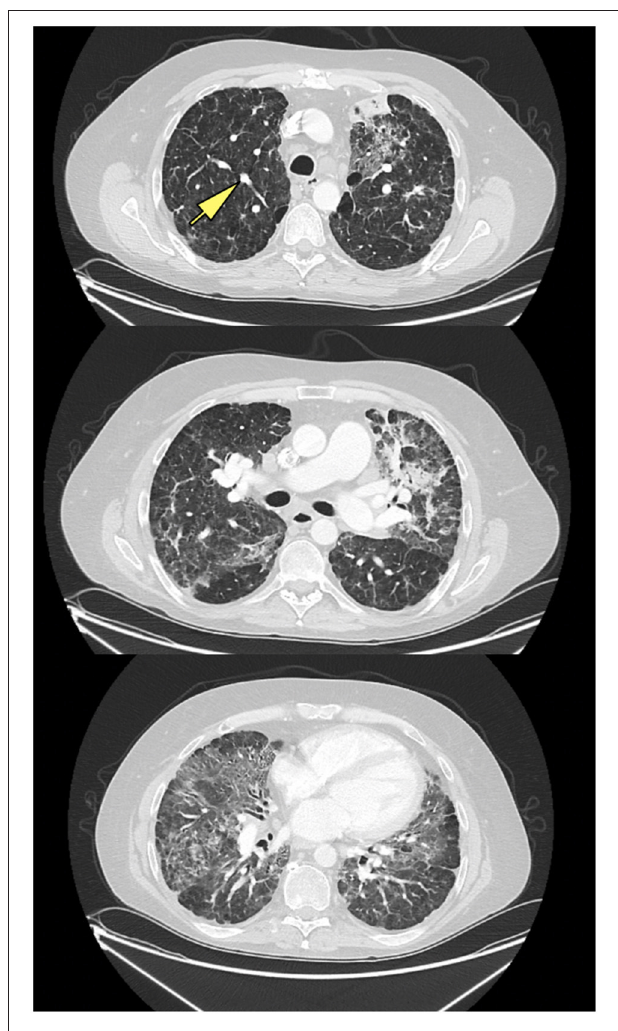
FIGURE 3 | CT scan of ILD/CVID patient, with upper, middle, and lower lung zones, demonstrating mid to lower lung zone predominant ground glass opacities, within a bronchovascular distribution, with associated volume loss, with left upper lobe consolidation in association with air bronchograms, likely pneumonia, new solid nodular opacity (12 × 7mm) (yellow arrow) in the right upper lobe, as well as bilateral hilar